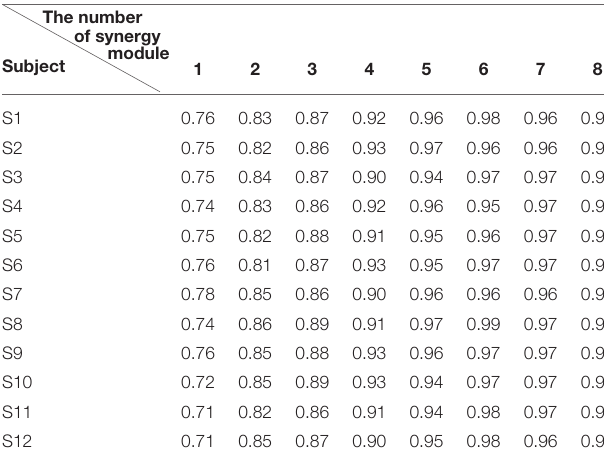
TABLE 1 | The VAF values under different numbers of the synergy module for all